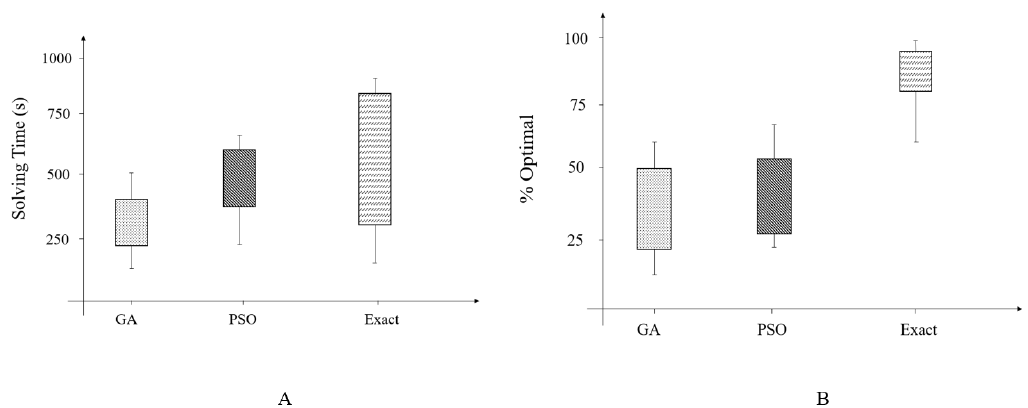
Figure 10. ( A ) Solving time and ( B ) percentage (%) optimality of solution quality comparison between the genetic algorithm (GA), particle swarm optimisation (PSO) and the exact approach.